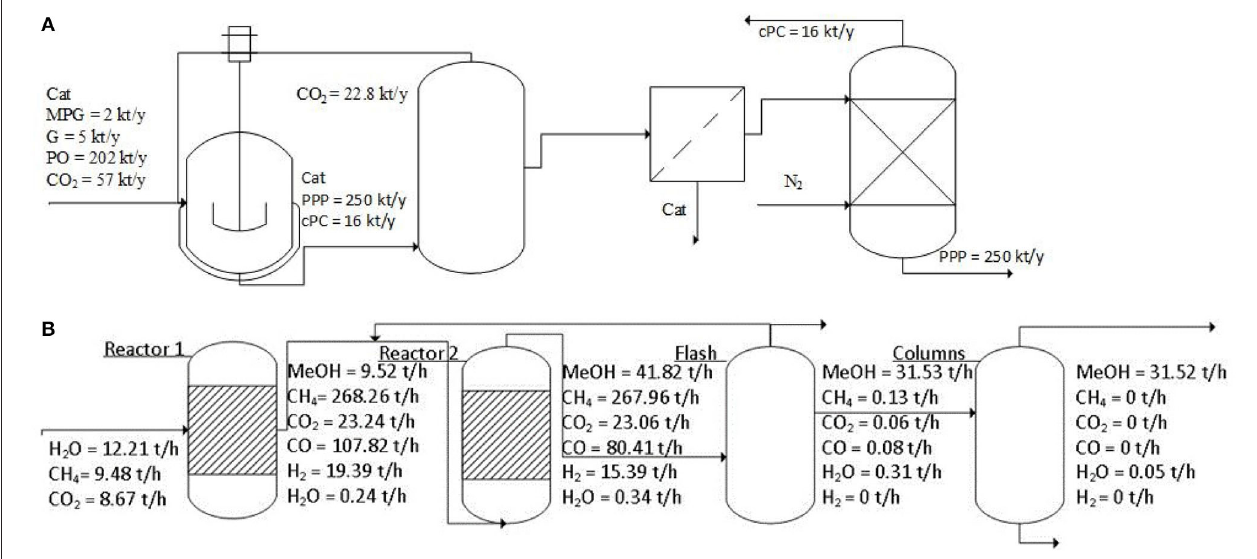
FIGURE 2 | Principal flowrates and conversion schemes for producing: (A) PPP (Fernández-Dacosta et al., 2017), or (B) MeOH (Wiesberg et al., 2016).